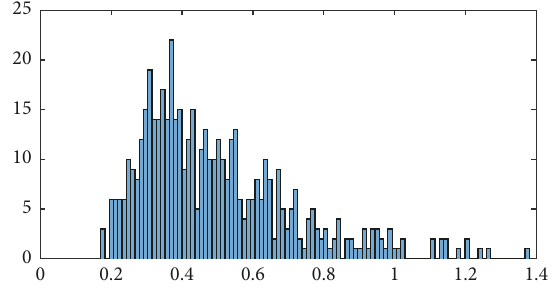
Figure 4: Distribution of 𝑆(𝑡) + 𝜂𝑉(𝑡) at time t =10